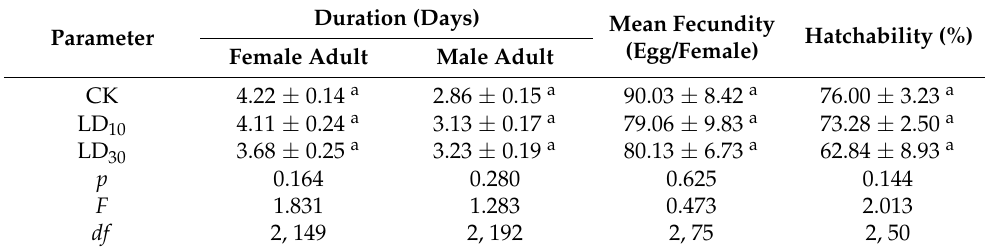
Table 4. Sublethal effect of fluxametamide on duration, mean fecundity and hatchability of F 0 C. suppressalis adults.